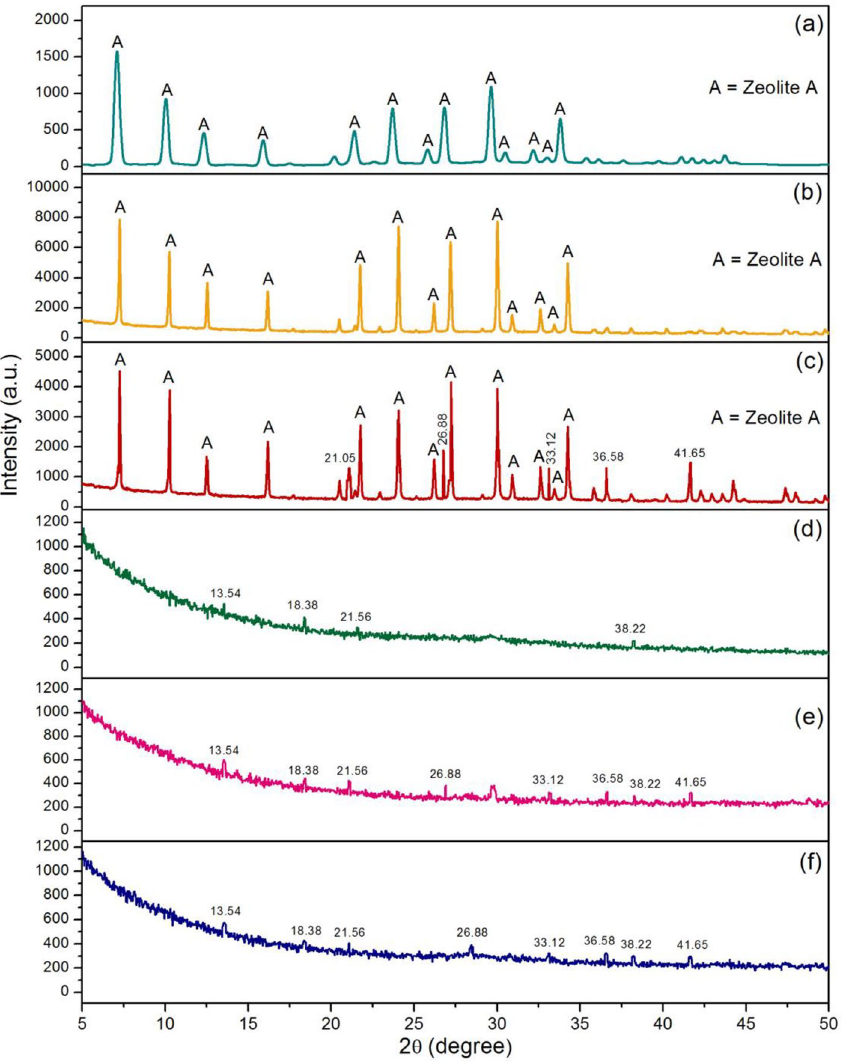
Figure 2. XRD patterns of ( a ) zeolite A standard (STD), ( b ) zeolite A sugarcane bagasse fly ash powder (ZB), ( c ) zeolite A sugarcane bagasse fly ash powder mixed iron(III) oxide-hydroxide (ZBF), ( d ) zeolite A